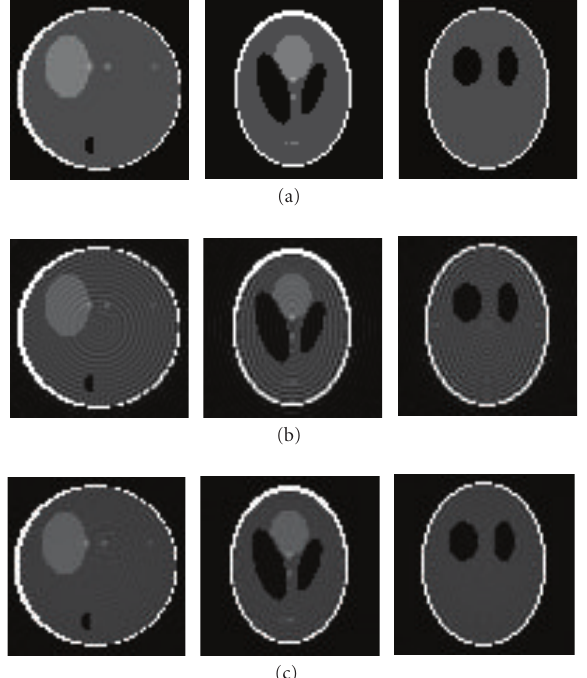
Figure 7: Three central orthogonal cross sections of the 64 × 64 × 64 Shepp-Logan phantom. (a) Original object. (b) Reconstruction from 3D radial k -space data with direct reconstruction, and (c) with leakage reduction reconstruction.